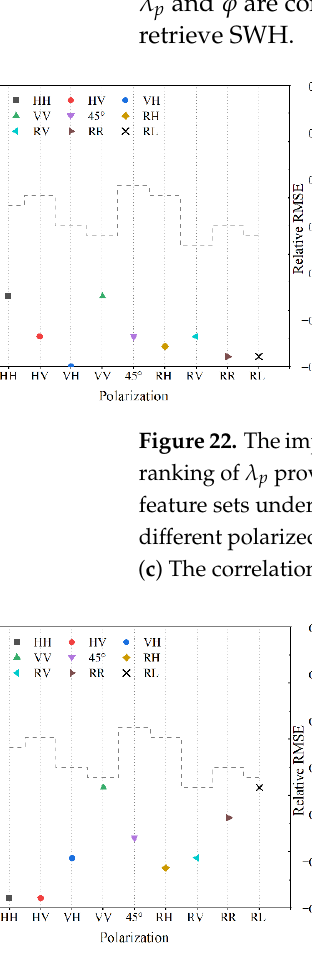
Figure 24. The importance of λ p to SWH retrieval from combined-polarization models. ( a ) The im- portance ranking of λ p provided by XGBoost models, normalized to the range of 0 – 1. ( b ) The effect of removing λ p on the SWH estimation from different polarized models. The red pentagrams repre- sent the relative RMSE corresponding to the removal of λ p -terms in the combined-polarization mod- els. Figure 25. The importance of φ to SWH retrieval from combined-polarization models. ( a ) The im- portance ranking of φ provided by XGBoost models, normalized to the range of 0 – 1. ( b ) The effect of removing φ on the SWH estimation from different polarized models. The red pentagrams repre- sent the relative RMSE corresponding to the removal of φ -terms in the combined-polarization mod- els. 4.6. The Importance of CWAVE Spectral Parameters The performance change of each model for SWH retrieval is caused by removing 20 CWAVE spectral parameters is explored, and the relative RMSE is shown in Figure 26. For the single-polarization models, the removal of spectral parameters makes the model